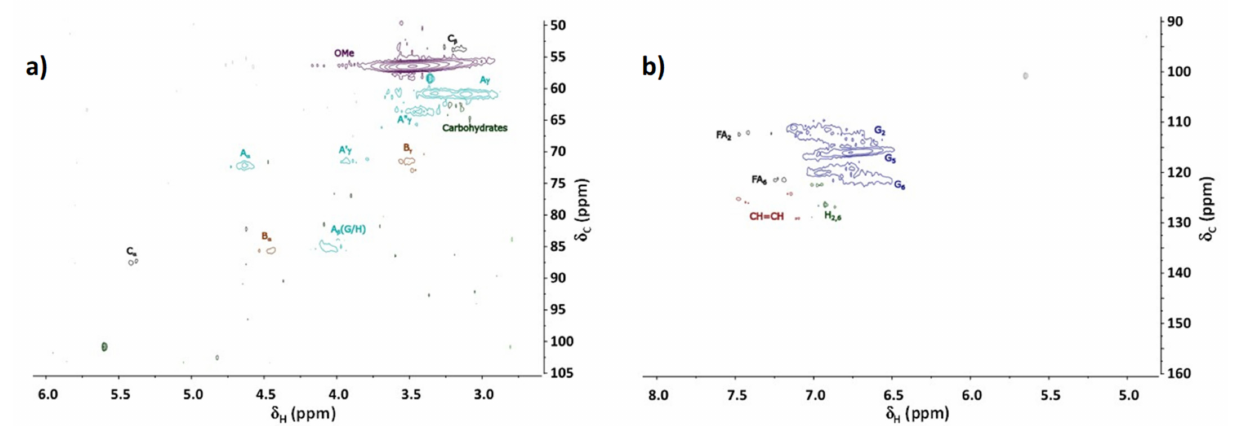
Figure 8. HSQC spectrum (48 scans) of initial Kraft lignin. ( a ) Oxygenated region; ( b ) aromatic